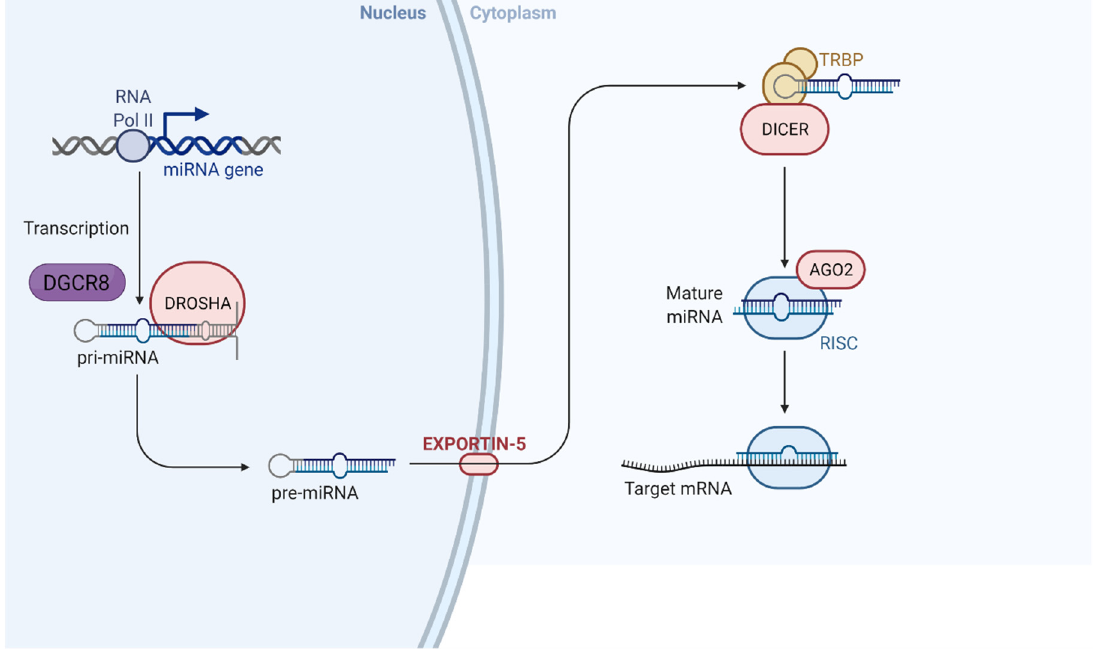
Figure 1. The mechanism of miRNA synthesis and action [20] (adapted from BioRender.com (accessed on 28 October 2021)). 2021 Copyright BioRender.